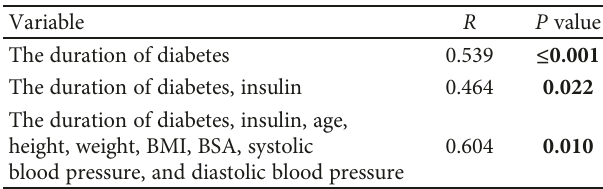
Table 3: Uni- and multivariable correlation analyses between ECV and the duration of